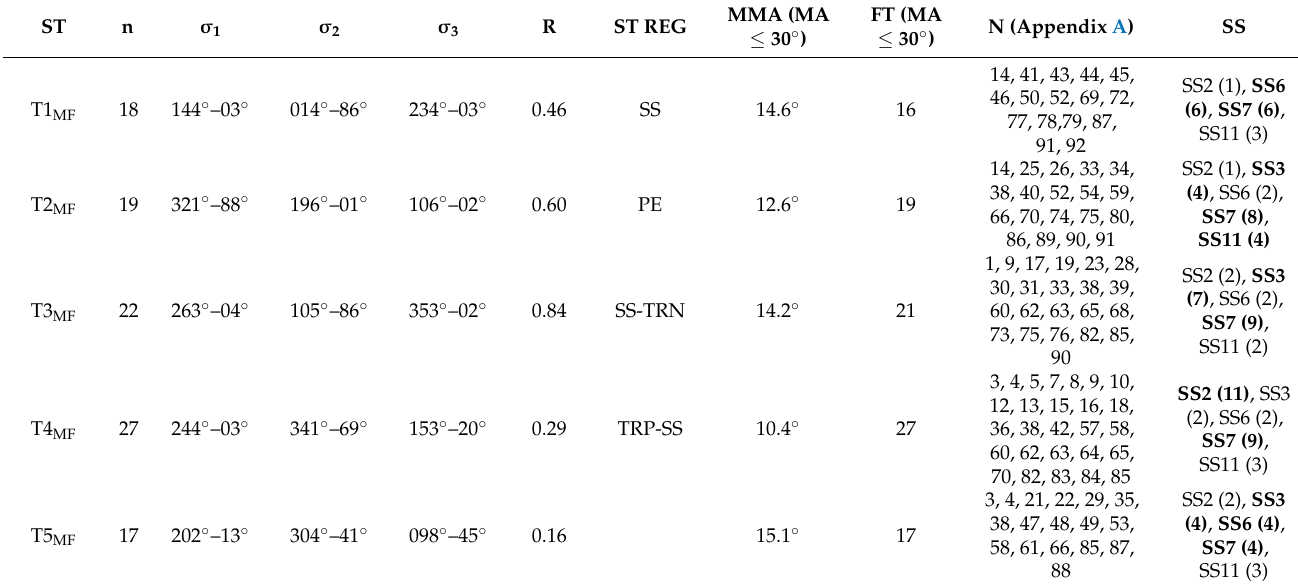
Table 5. Best-fit stress tensors from the fault-slip data driven by the enhanced Andersonian bulk stress tensors.